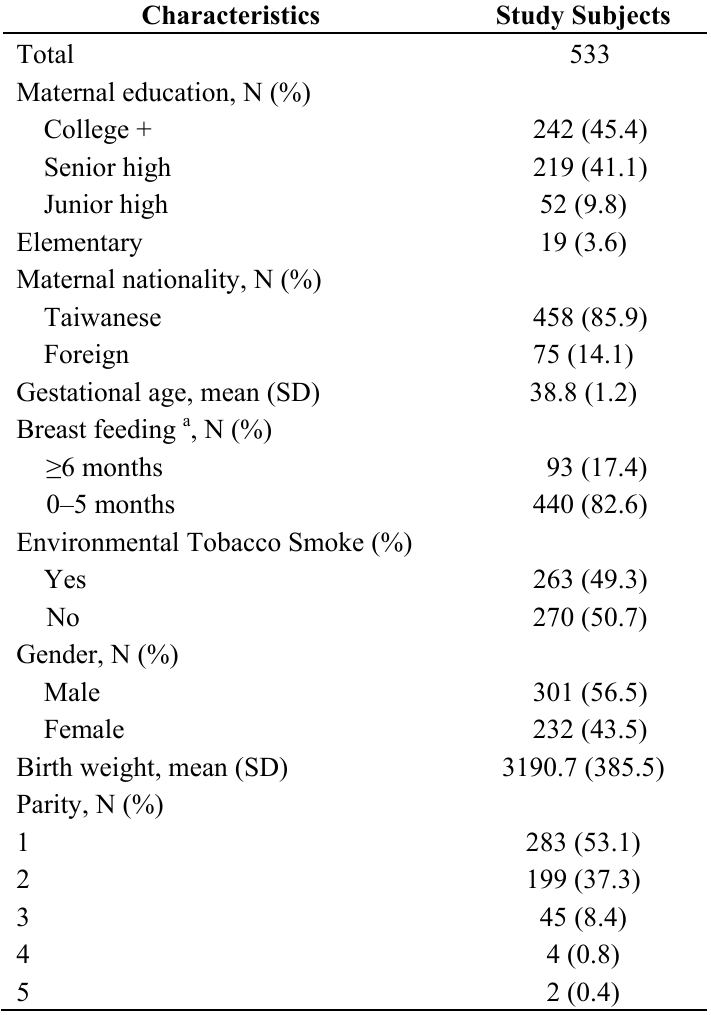
Table 1. Characteristic of the study